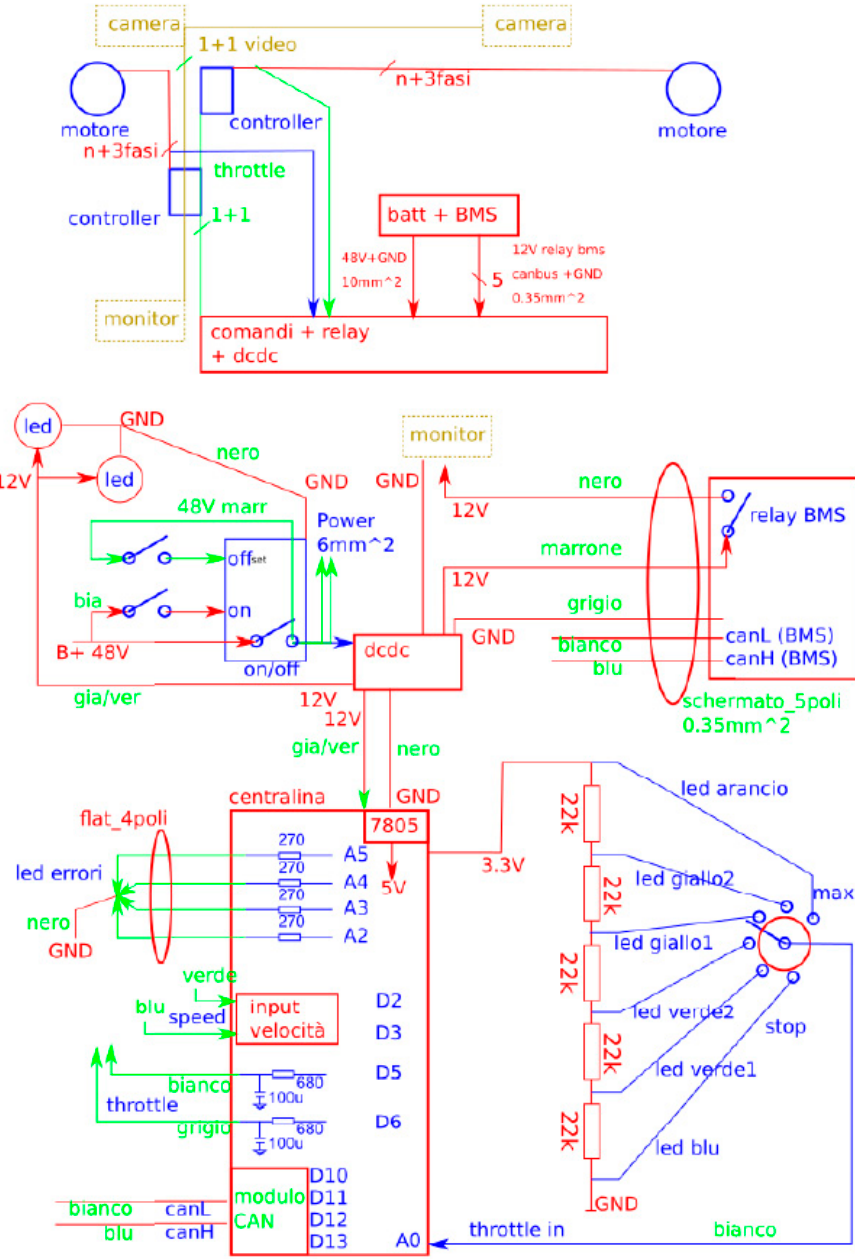
Figure 13. General scheme of the